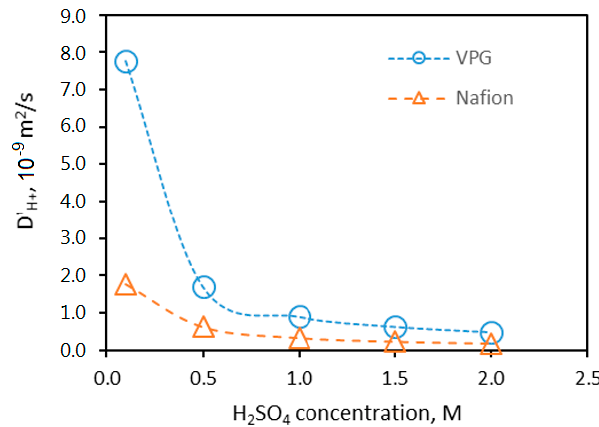
Figure 10. Proton diffusivity in the VPG and Nafion membranes as a function of H 2 SO 4 concentration in the solution.